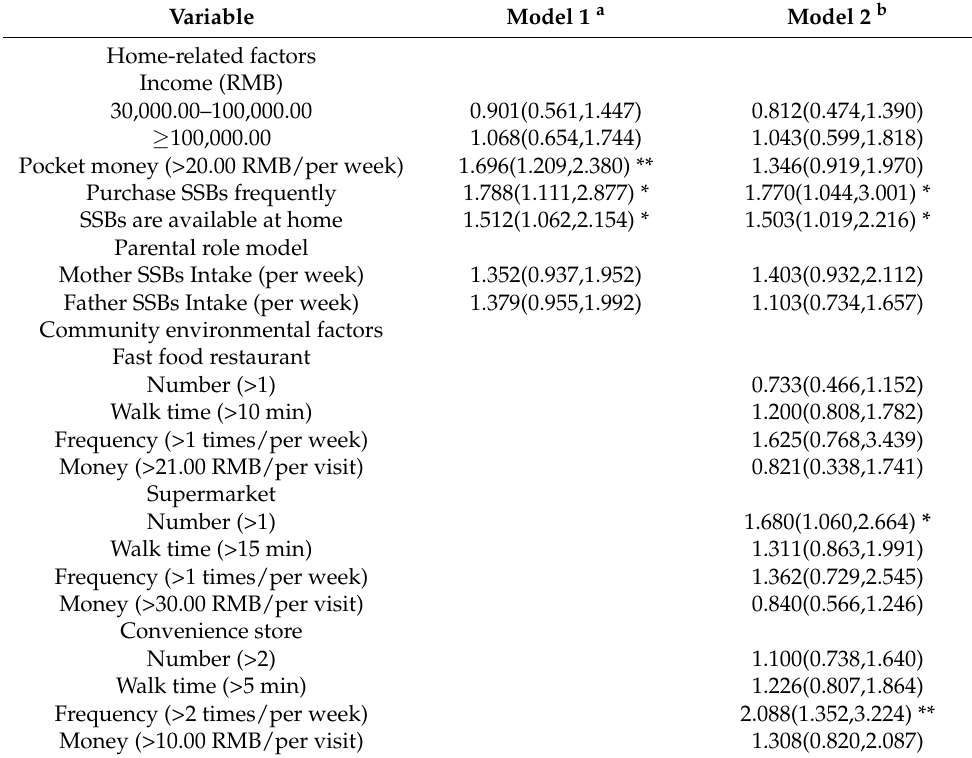
Table 4. Factors associated with sugar-sweetened beverages intake in participants.